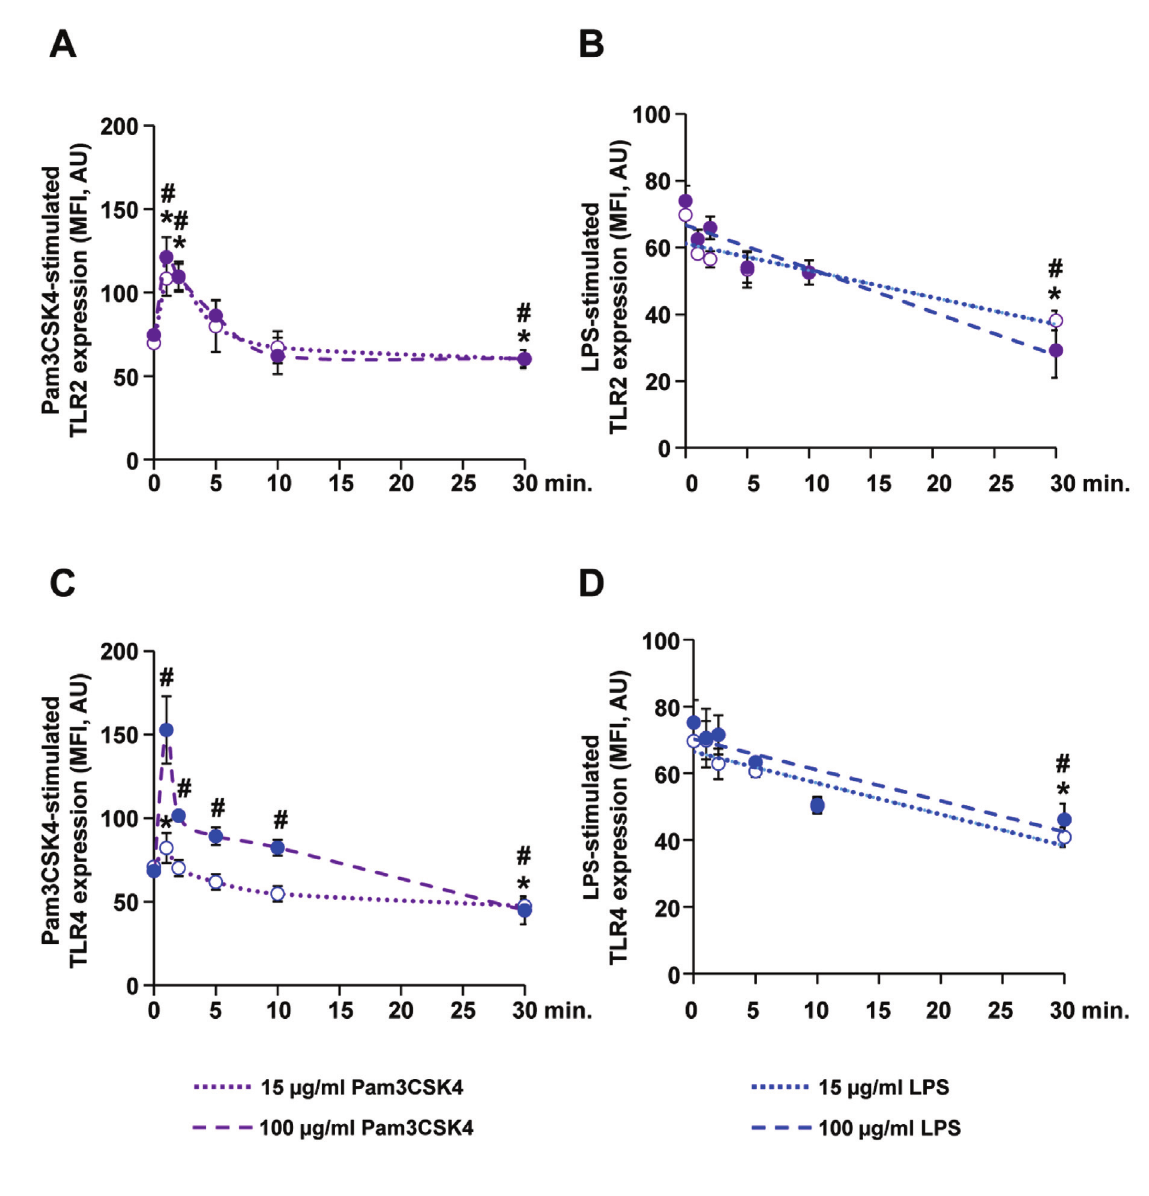
Fig. 2 Pam3CSK4 induces a transient increase of TLR2 and TLR4 expression. TLR2 (purple circles) and TLR4 (blue circles) expression was measured in WP by fl ow cytometry after stimulation with 15 or 100 µg/mL of Pam3CSK4 (purple dotted line), (A and C) and 15 or 100 µg/mL of LPS (blue dotted line) (B and D) . Data are presented as mean MFI (cid:3) SEM; n ¼ 3; (cid:4) : p < 0.05; compared with control (0minute), for 15 µg/mL of TLR ligands; # p < 0.05; compared with control (0minute), for 100 µg/mL of TLR ligands. LPS, lipopolysaccharides; SEM, standard error of mean; TLR, toll-like receptor; WP, washed